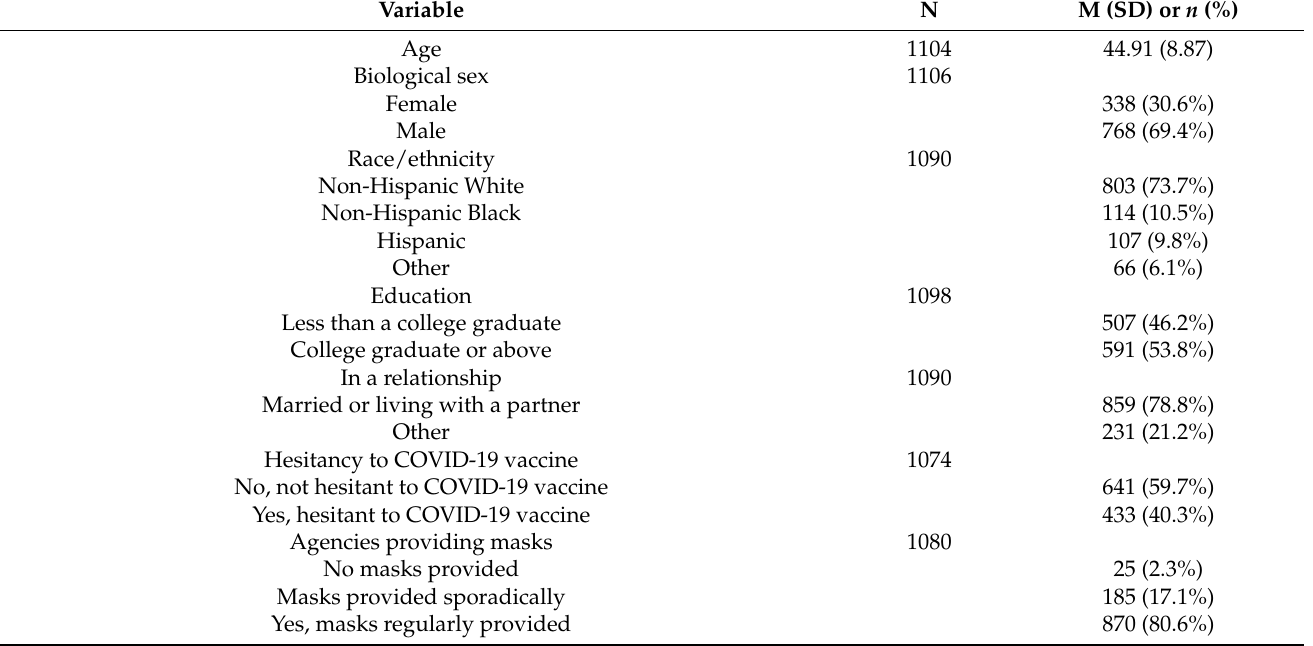
Table 1. Descriptive analysis of study